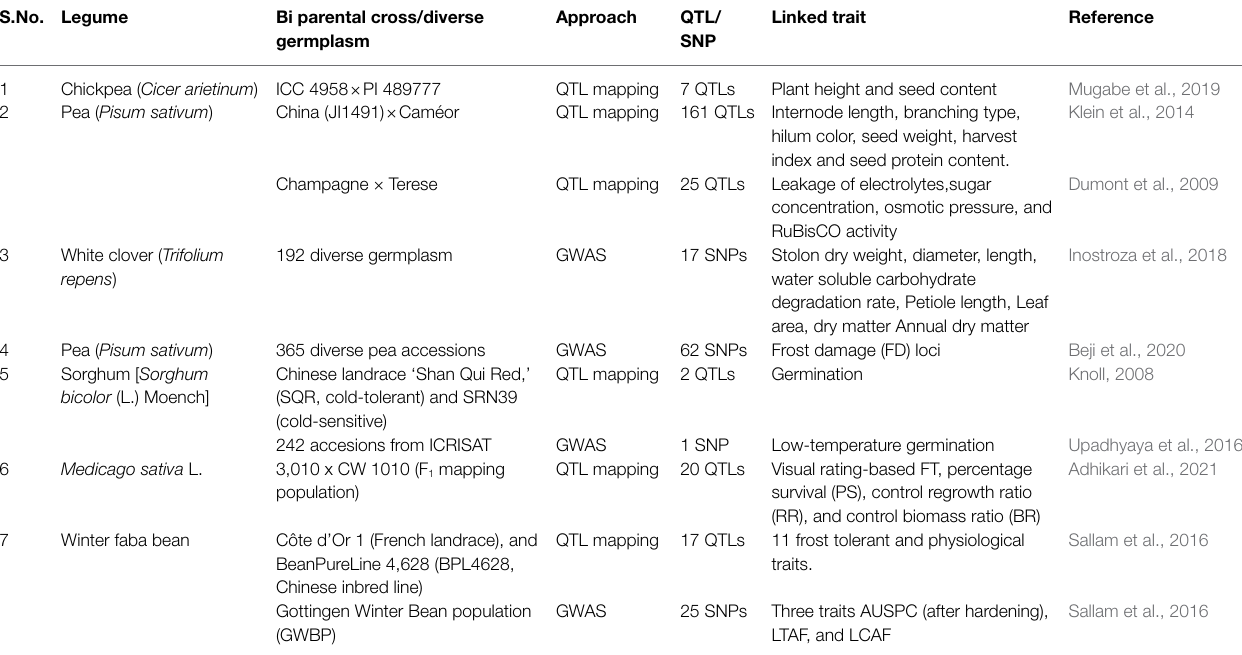
TABLE 2 | Various QTLs/SNPs identified in different legumes under cold stress that can be used in MAS/MAB for cold tolerance in legumes. S.No.